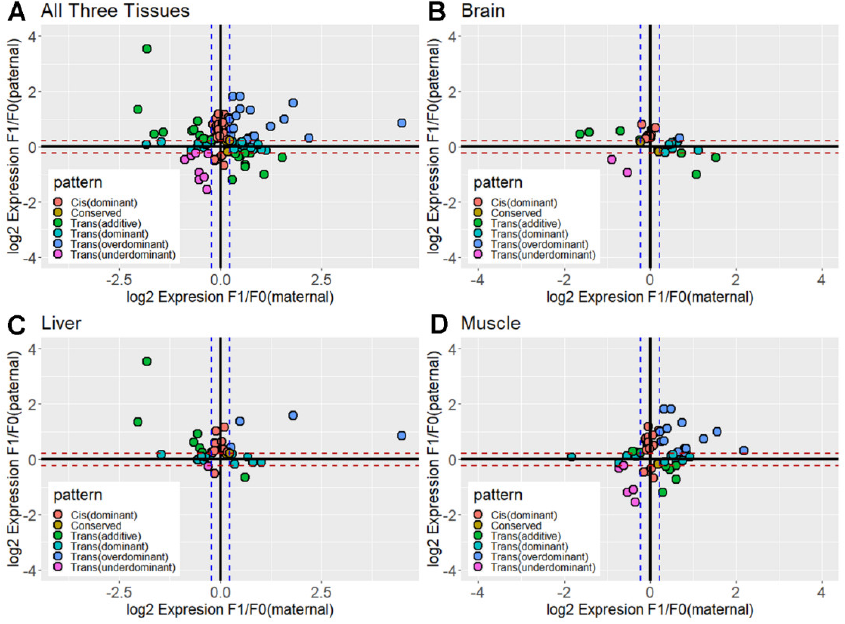
divergence categories. Log 2 Expression F1/F0(maternal) on the X-axis specifically includes two cases, namely log 2 Expression CL/Cor or log 2 Expression LC/WL, corresponding to the two cases on the Y-axis, log 2 Expression CL/WL or log 2 Expression